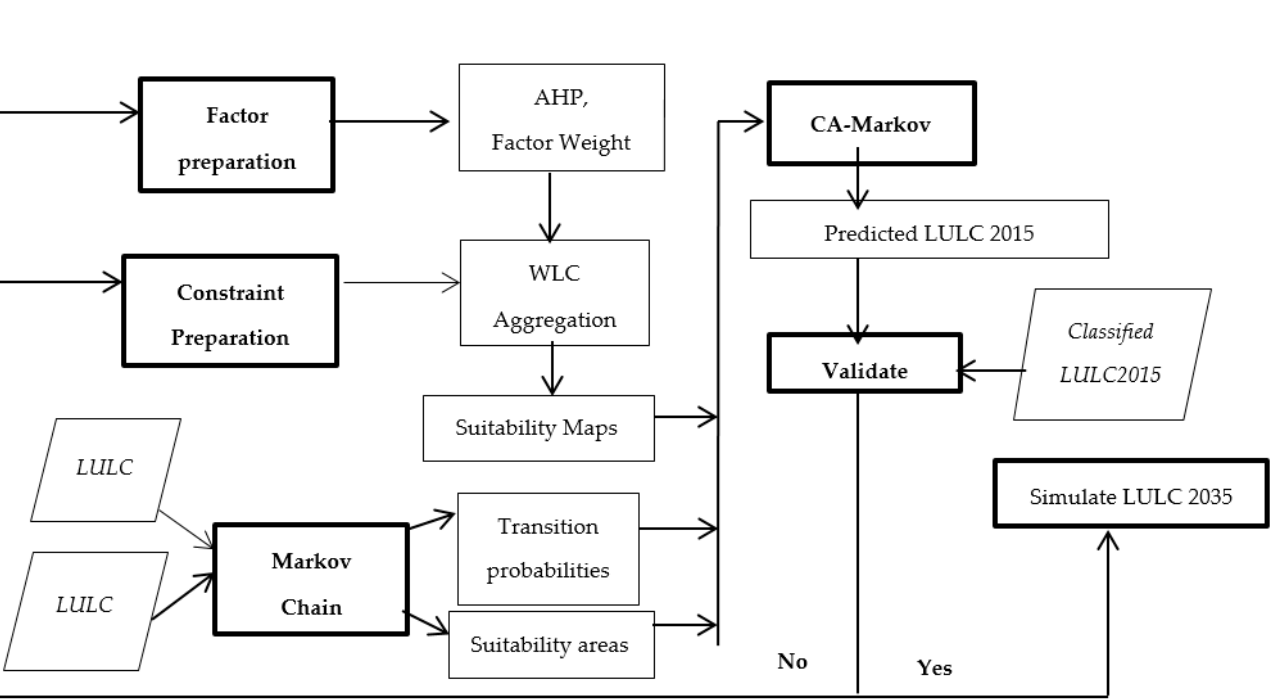
Figure 3. Modelling framework for LULC change simulation.